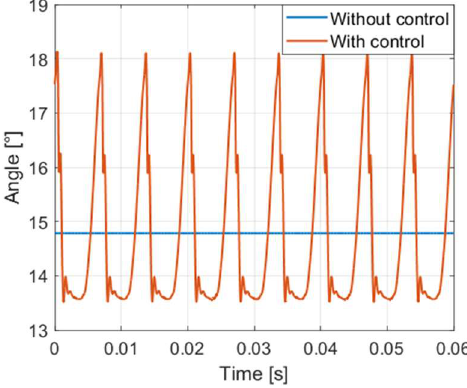
Figure 11. Ideal model. Swash plate position. Shaft speed 1000 r/min.